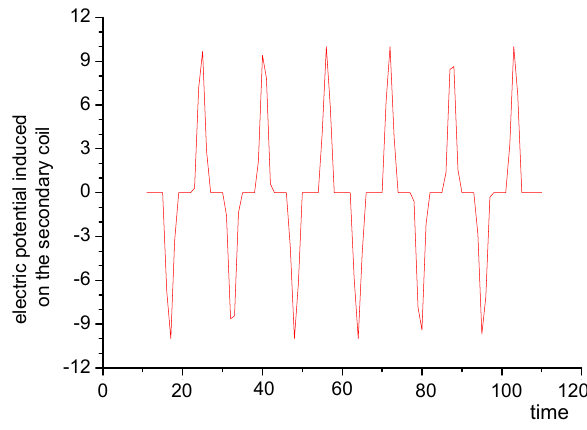
Figure 126: Time derivative of the curve 𝐵 = 𝐵 1 + 𝐵 2 shown in Figure 125 assuming the magnetic flux is referred to a unitary